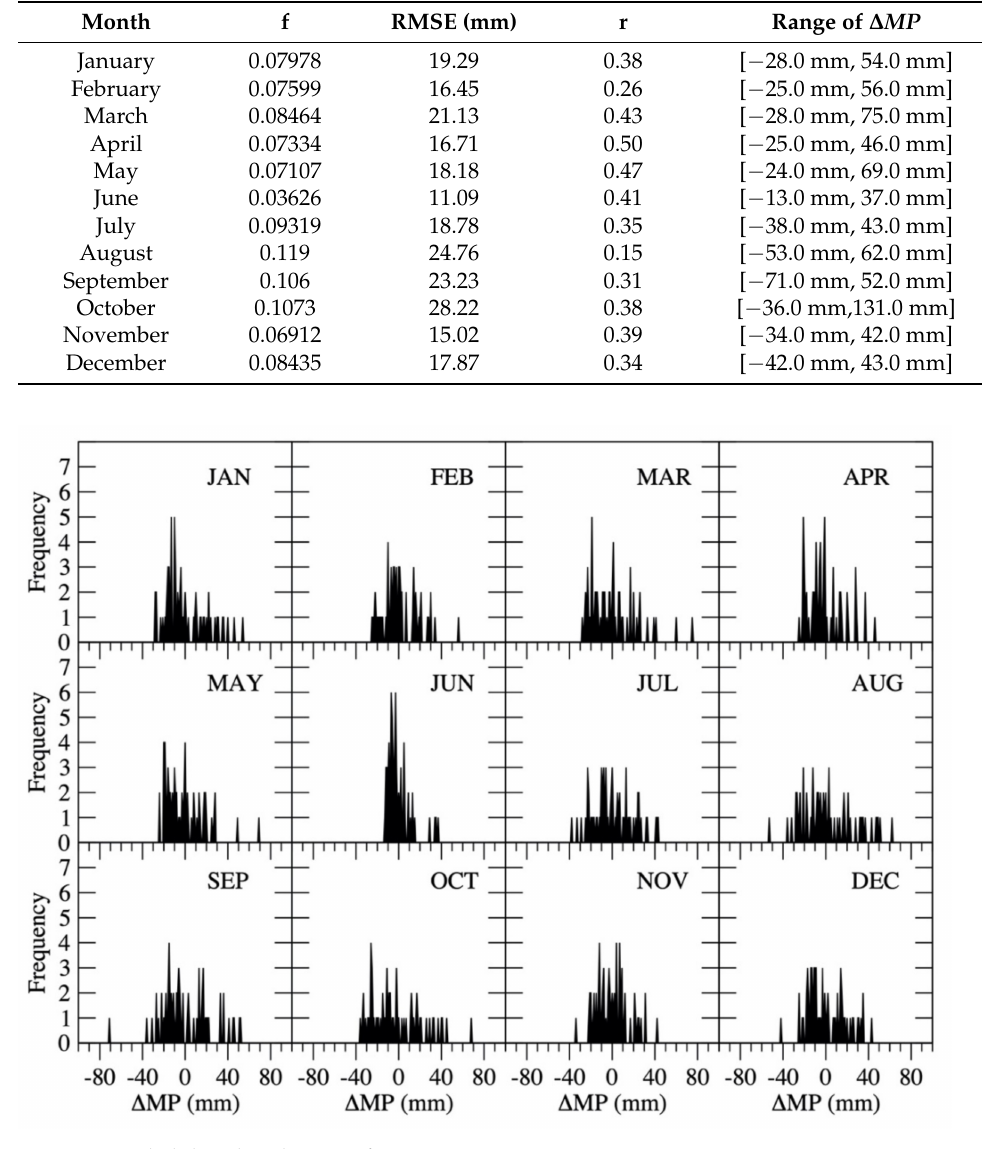
Figure 8. Probability distribution of ∆ MP